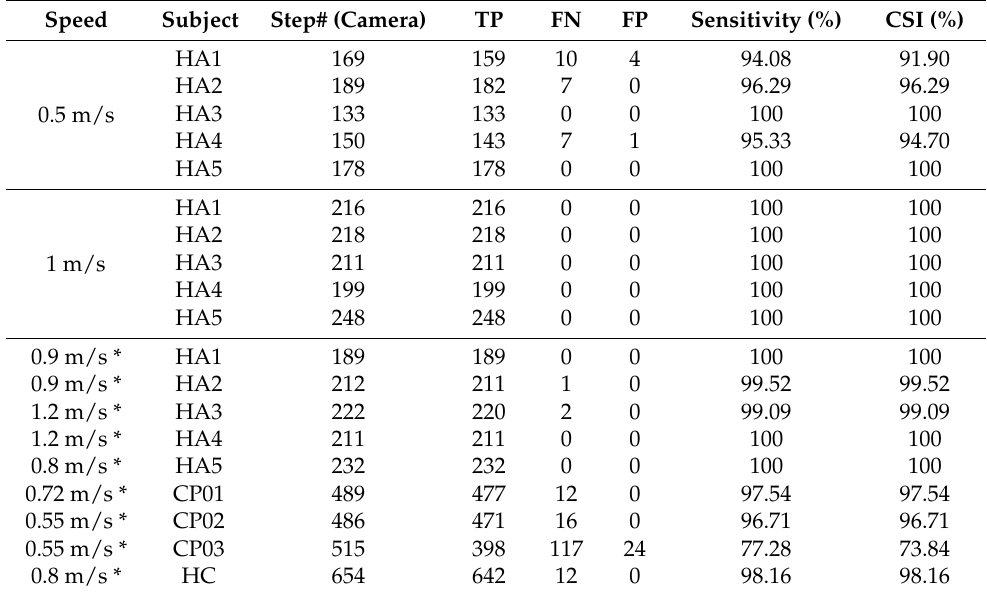
Table 2. EMG performance in five healthy adults (HA) at three different treadmill speeds in three children with unilateral CP and one healthy child (HC). * preferred